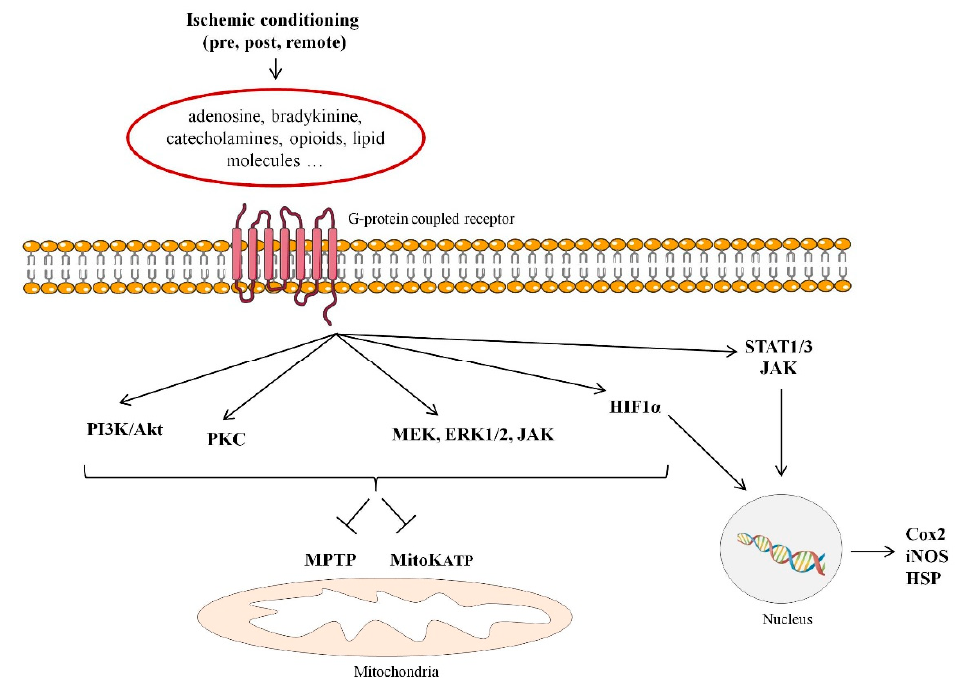
Figure 1. Signaling pathways involved in ischemic conditioning-induced cardioprotection.